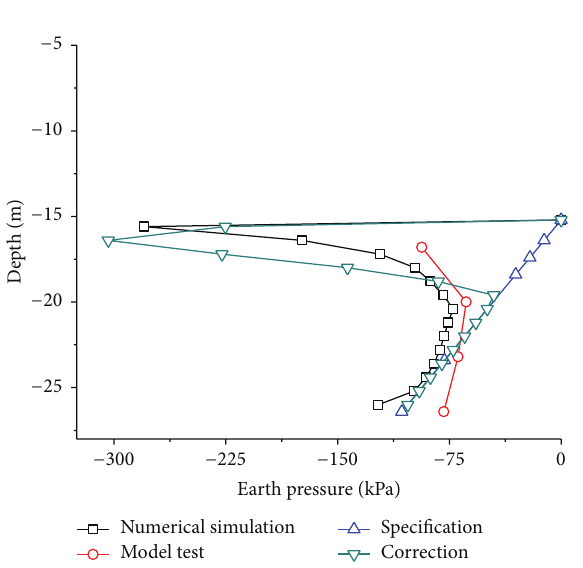
Figure 9: Earth pressure of front of back-row